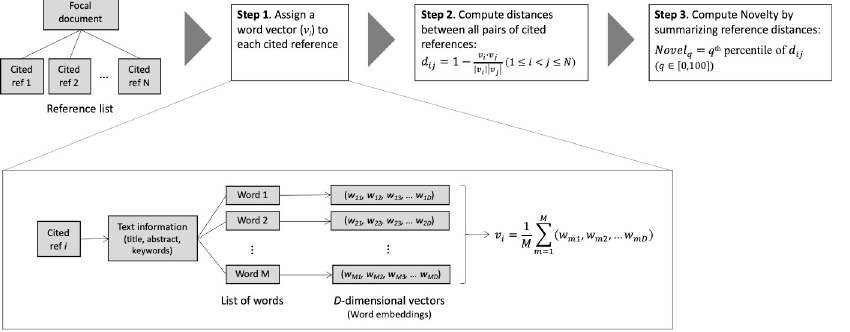
Fig 1. Algorithm of novelty